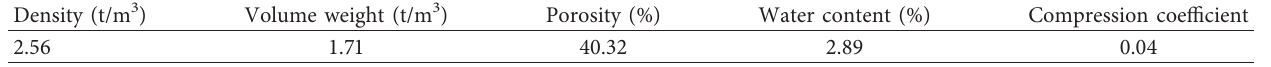
Table 2: Test results of physical parameters of coal zircon.